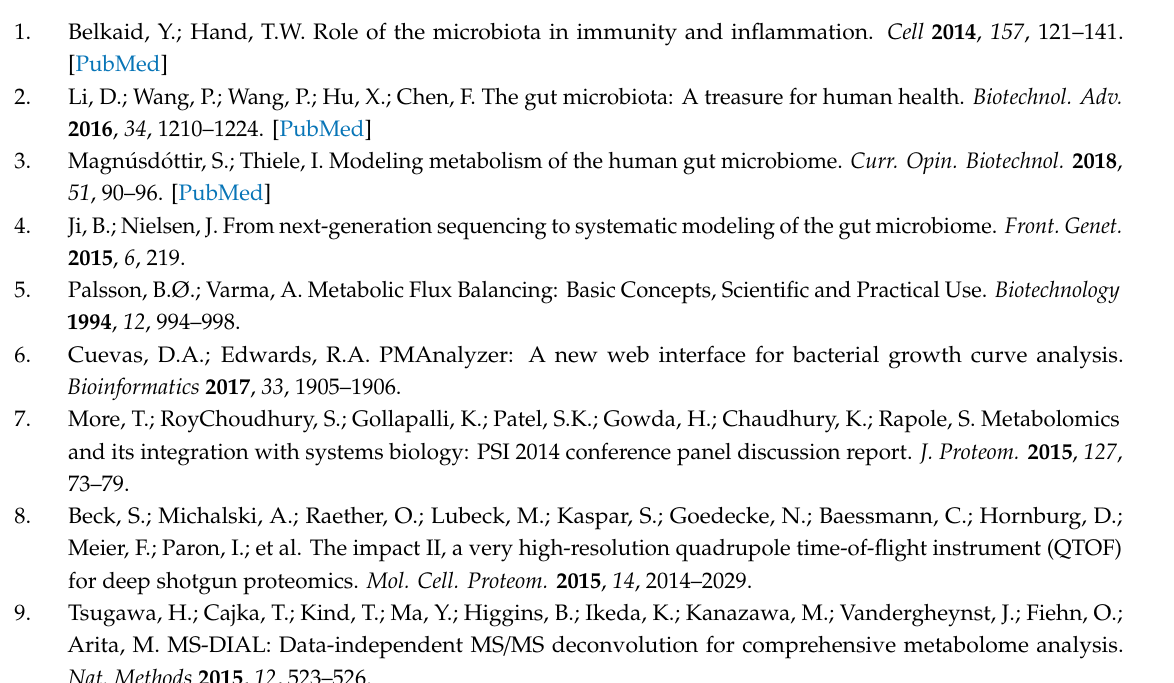
Figure S1: (a) This graphical output from MS_FBA shows all 1097 significant features from the XCMS Online results for the reverse phase positive mode run. The red dots show the intensity di ff erence between the late (L) and mid (M) sample points, and the blue shows the intensity di ff erence between stationary (S) to late (L); (b) This graph shows all features that were not matched to the compounds from the predicted compound list, Table S1: Features matched to the PyFBA predicted metabolites in the reverse phase run with data acquisition in positive mode, Table S2: Features matched to PyFBA predicted metabolites in the HILIC run with data acquisition in negative mode, Table S3: Adducts with the ionization mode that they are present in and the mass change that occurs to the compounds mass (M), Table S4: XCMS Online method parameters “UPLC / Bruker Q-TOF pos” method for each LCMS